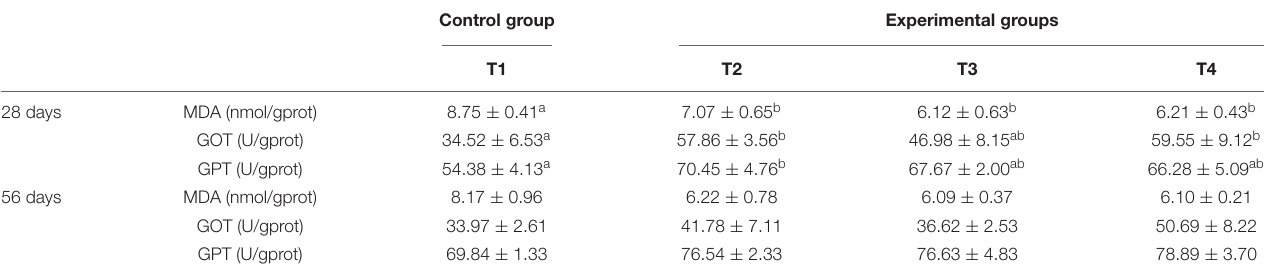
TABLE 4 | Effects of autochthonous probiotics on liver biochemical indices of grouper ( E. coioides ) fed diets with high levels of